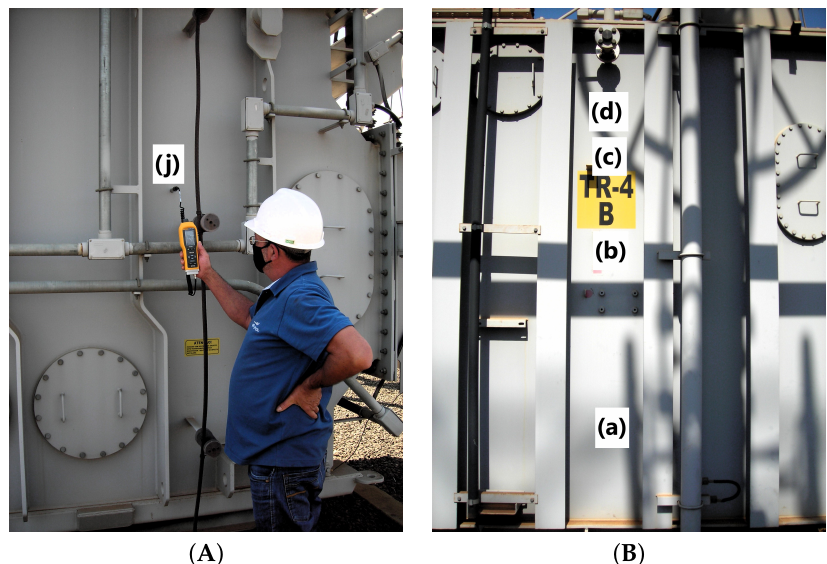
Figure 3. Pictures of the vibration measurement: ( A ) one of the measured positions; ( B ) different measured points.